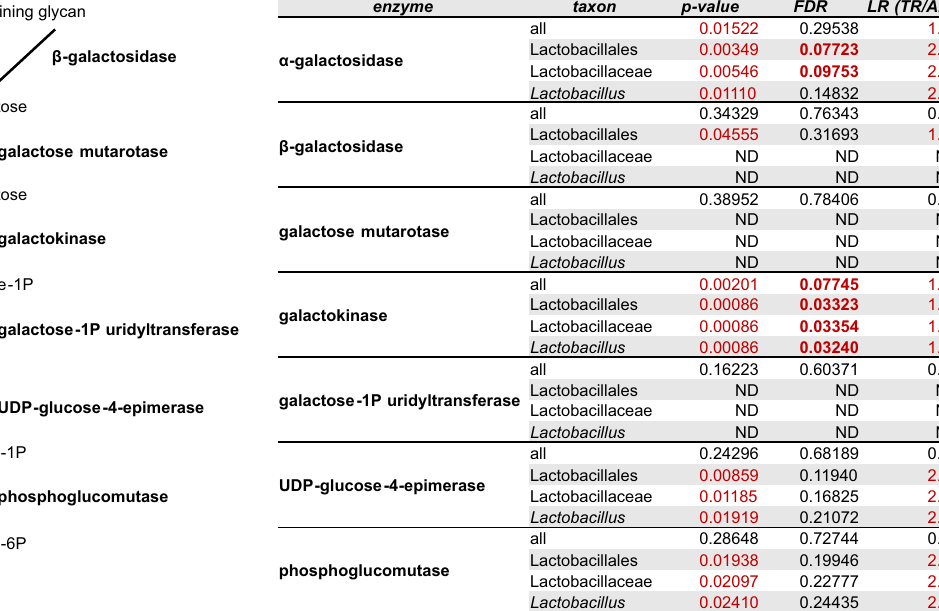
Fig. 6 Leloir pathway, galactose metabolism, and lactobacilli in the fecal microbiota of TR- vs. AL-fed rats. Left, schematic representation galactose metabolism enzymes (bold) and metabolites, with focus on the Leloir pathway. Right, taxonomic annotation of Leloir pathway/ galactose metabolism enzymes detected in the samples analyzed in this study. p -value, FDR, and log-ratio (LR) value obtained upon TR vs. AL differential analysis are reported for each enzyme-taxon combination. p -values < 0.05, FDRs < 0.1 and LRs > 1 are shown in red; FDR values < 0.1 are also in bold. ND, not detected (or not passing the fi